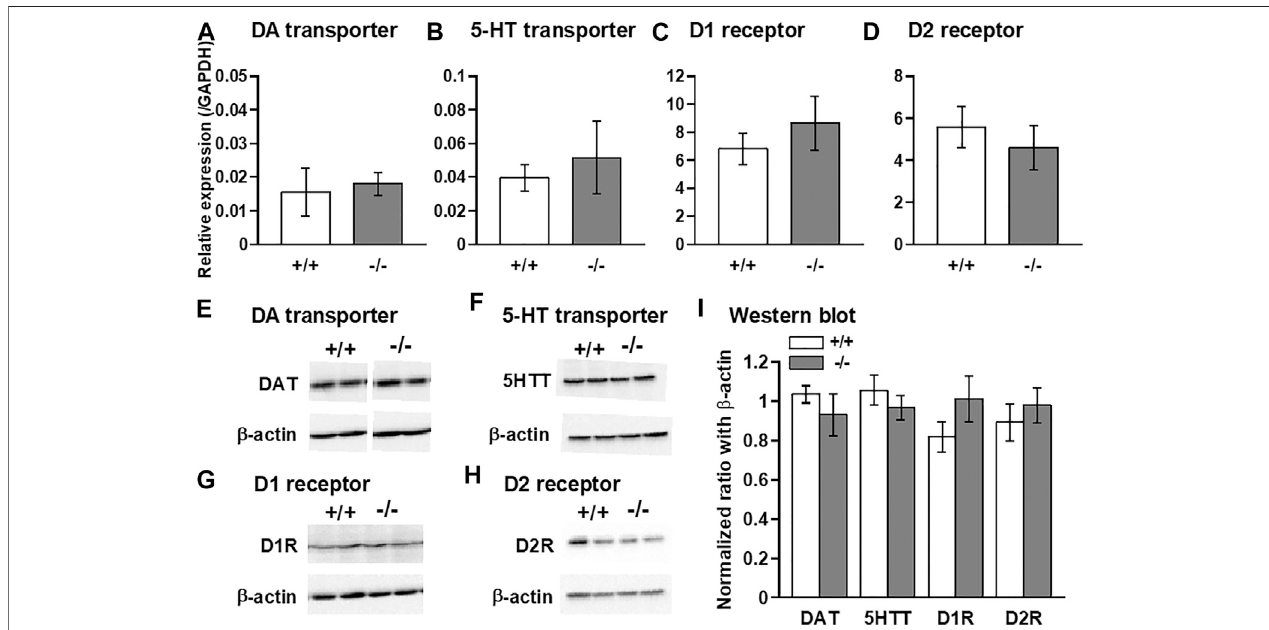
FIGURE 7 | Quantitative PCR and western blot analyses of DA and 5-HT transporters, and dopamine D1 and D2 receptors in the striatum. qPCR (A – D) and western blot (E – I) analyses showing that no signi fi cant differences in the expression levels of DA transporter (DAT: A,E,I ), 5-HT transporter (5HTT: B,F,I ), D1 receptor (D1R: C,G,I ), and D2 receptor (D2R: D,H,I ) were observed between FFAR1+/+ and − / − mice. n (cid:2) 6 (A) and 5 (B-D) each. In (I) , n (cid:2) 4 (+/+) and 6 ( − / − ) for DAT, n (cid:2) 8.